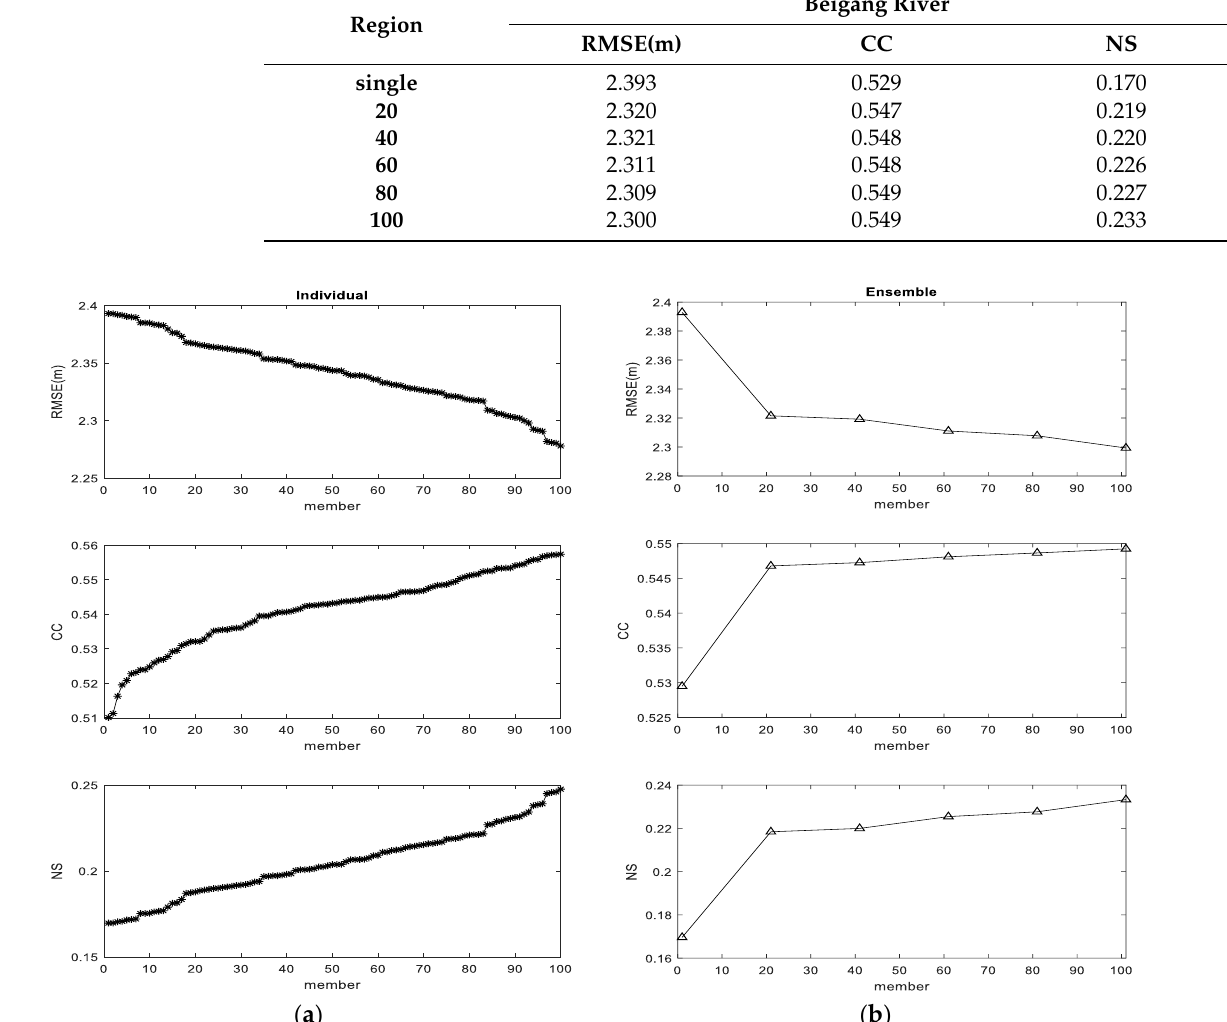
Figure 3. Simulation performance obtained from ( a ) individual member; ( b ) different ensemble sizes in Beigang River.